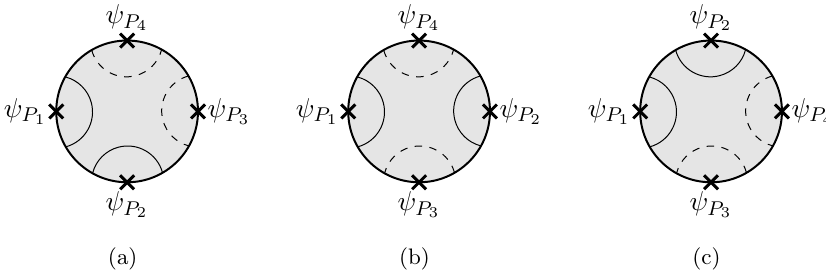
Figure 8 . Three of the Liouville disc diagrams that contribute to long + long ! long + long string scattering. The other three diagrams (not shown) are related by exchanging P 3 $ P 4 . The solid and dashed lines represent incoming and outgoing long strings respectively. Diagrams (a) and (c) are suppressed as the interaction between the incoming strings occurs on the